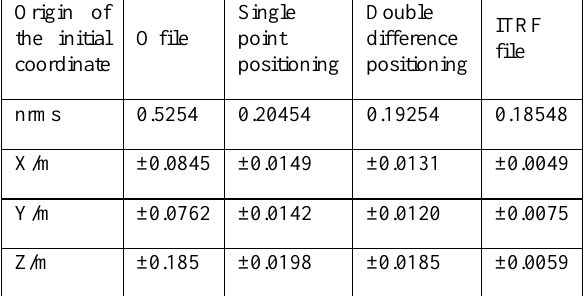
Table 1. Baseline solution results